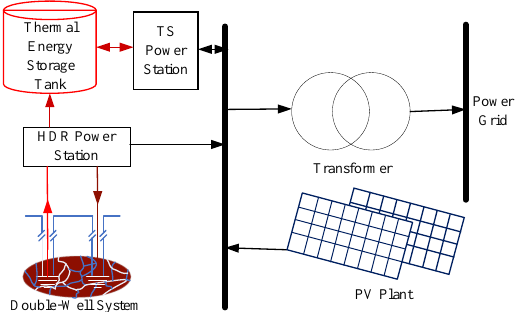
Figure 1. Architecture of the hybrid power system.